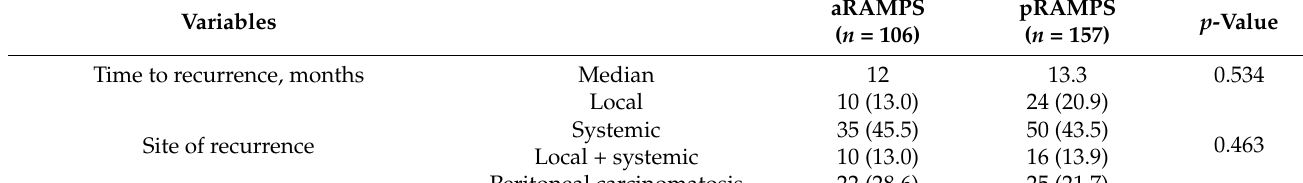
Table 7. Oncologic outcomes of radical antegrade modular pancreatosplenectomy among patients without periadrenal infiltration.